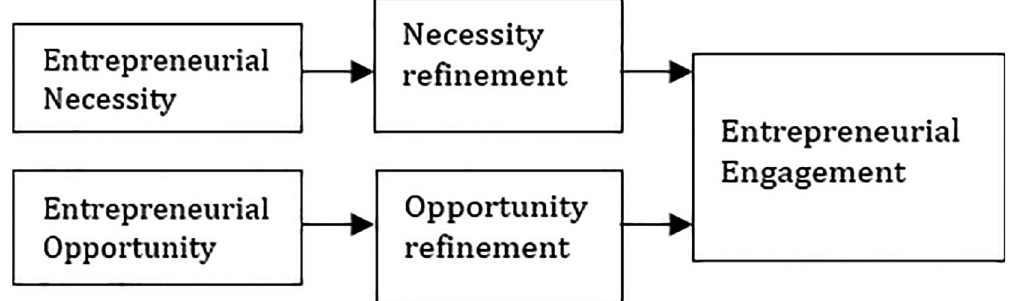
Figure 1. Proposed framework. Adapted from Ref.